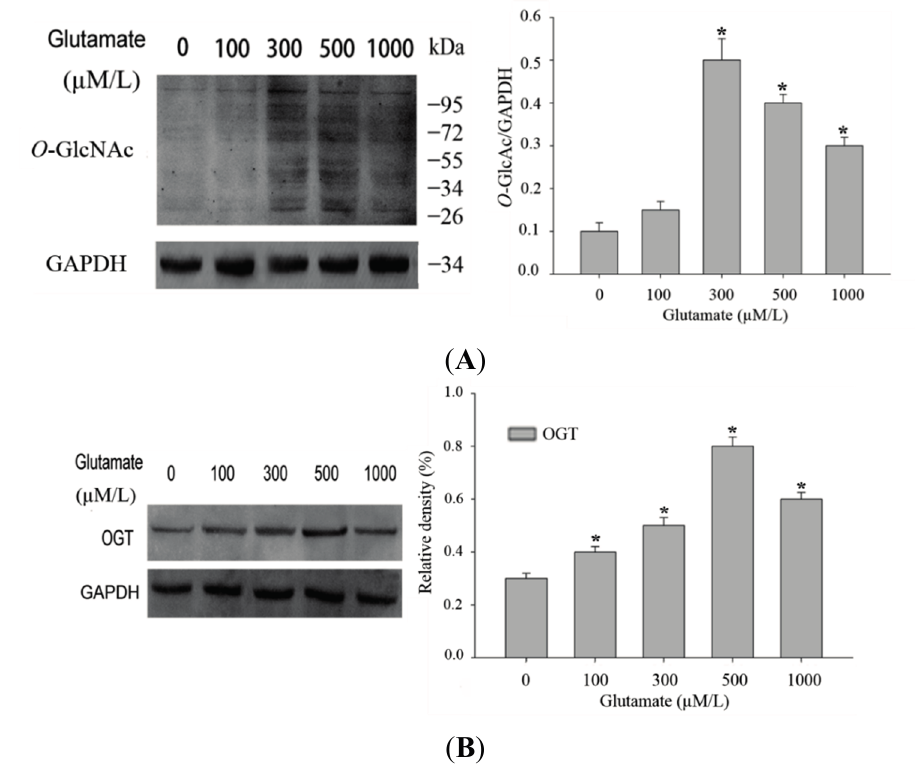
Figure 1. Alteration in O -GlcNAcylation of proteins after glutamate stimulation for 12 h in Rat pheochromocytoma (PC12) cells. ( A ) Cells were incubated with glutamate culture medium at concentration of 0, 100, 300, 500, 1000 μ M/L separately. Proteins in cell lysates were subjected to sodium dodecyl sulfate (SDS)-polyacrylamide gelelectrophoresis (PAGE) and immunoblot analysis with anti- O -GlcNAc antibody (CTD110.6). The lane labeled 0, represent cells without glutamate stimulation, and the lanes labeled 100, 300, 500 and 1000 represent cells treated with 0, 100, 300, 500, 1000 μ M/L glutamte respectively. The data are mean ± SEM. ( * p < 0.05, significantly distinct from the group without glutamate treatment); ( B ) The expression level of OGT ( O -GlcNAc transferase) was detected by Western blot. The data are mean ± SEM. ( * p < 0.05, significantly distinct from the group